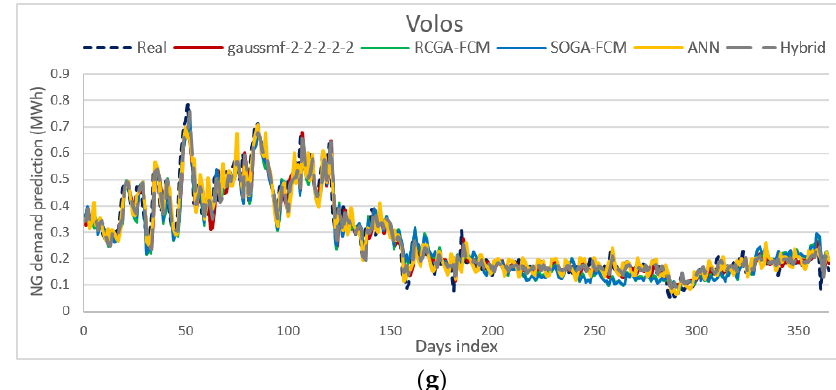
Figure A1. Comparison of forecasting results for each city considering all examined methods. ( a ) Testing for Karditsa, ( b ) testing for Larissa, ( c ) testing for Markopoulo, ( d ) testing for Serres, ( e ) testing for Thessaloniki, ( f ) testing for Trikala, ( g ) testing for Volos.